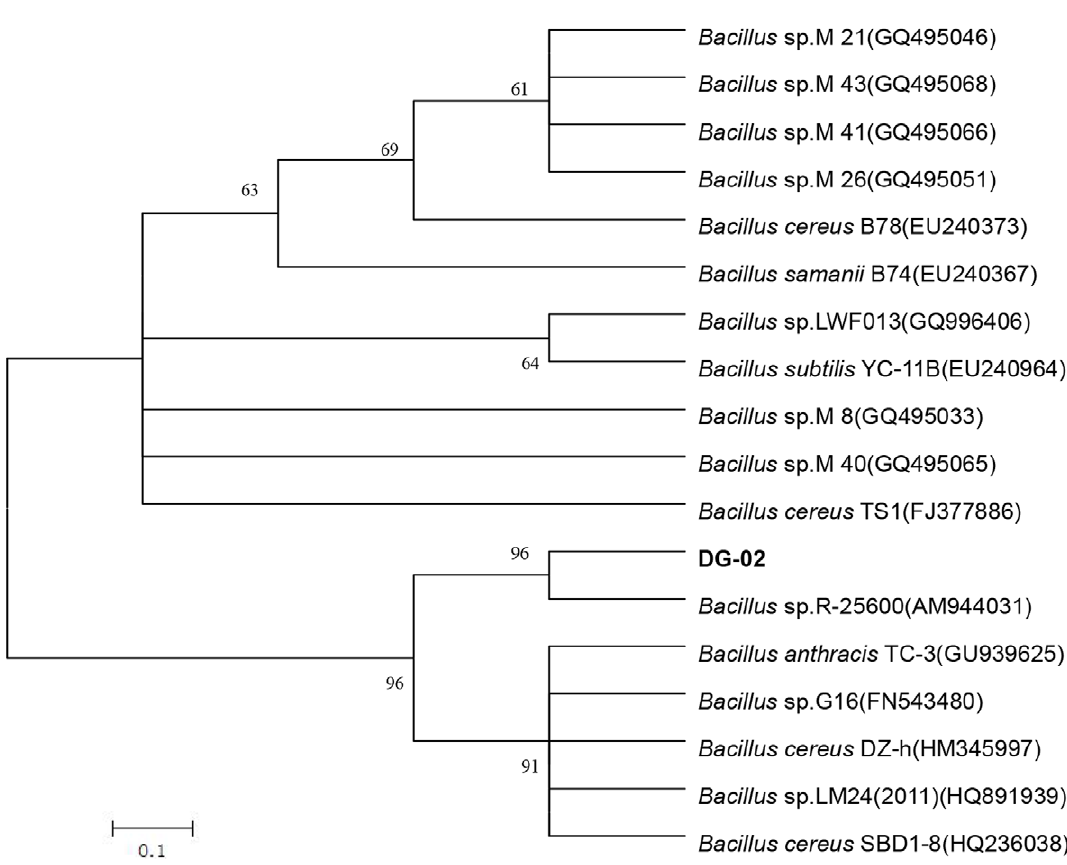
Figure 1. Phylogenetic tree based on the 16S rRNA sequences of strain DG-02 and related strains. Numbers in parentheses represent the sequences accession number in GenBank. Numbers at the nodes indicate bootstrap values from the neighborhood-joining analysis of 1,000 resampled data sets. Bar represents sequence divergence.